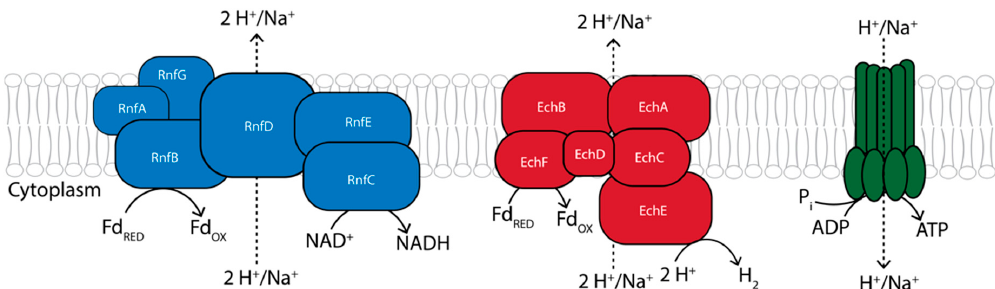
Figure 4. Membrane-bound enzymes for energy conservation in MCFA-producing bacteria. The RNF complex couples the reduction of NAD+ with Fd RED with ion translocation to generate an ion motive force. Similarly, energy-conserving hydrogenase couples the reduction of protons with Fd RED to ion translocation. The ion motive force is consumed by ATP synthase to produce ATP.